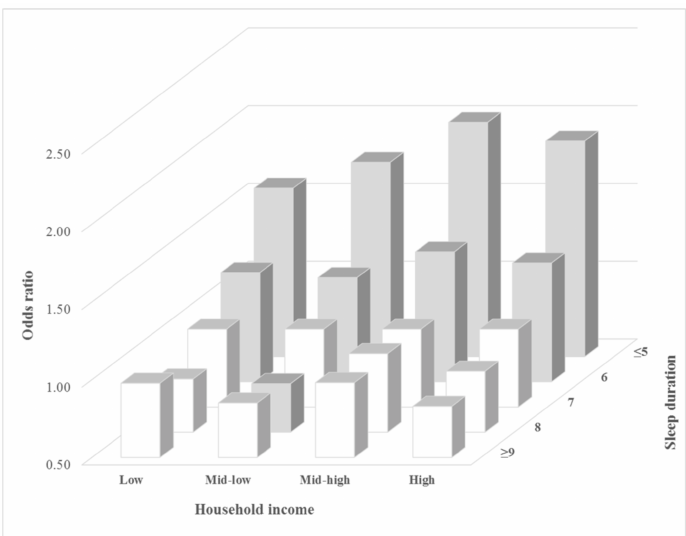
Figure 2. Subgroup analysis results for high-stress awareness according to household income and sleep duration. Gray bar shows that the results of the multiple logistic regression were statistically significant ( p -value < 0.05). Analyses were adjusted for the following covariates: age, educational level, household income, occupational categories, marital status, physical activity, alcohol consumption, smoking status, BMI, perceived health status, depressed mood, and chronic disease.